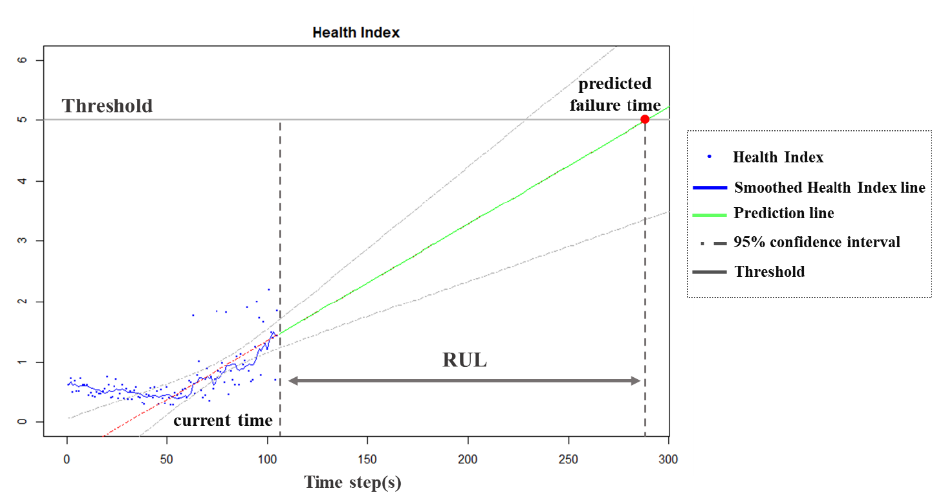
Figure 3. The example of the Health Index and the RUL prediction.